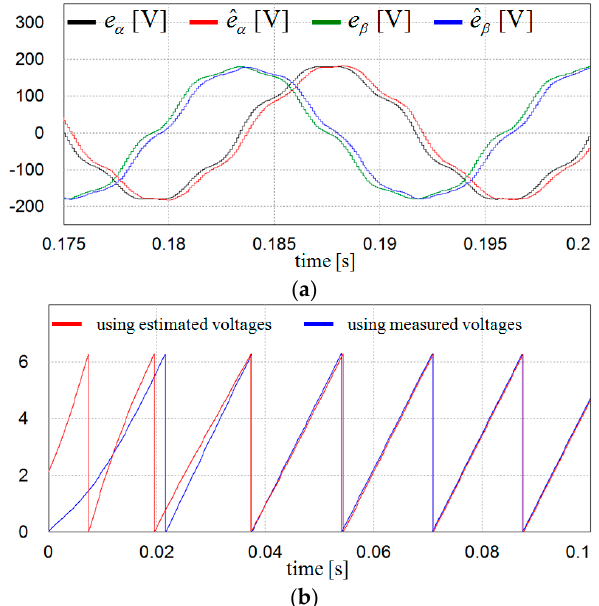
Figure 8. Estimation of grid voltages and phase angle using DOB under harmonic distorted grid condition. ( a ) Measured and estimated stationary q -axis and d -axis grid voltages; and ( b ) PLL results using measured voltages and estimated voltages at start-up.